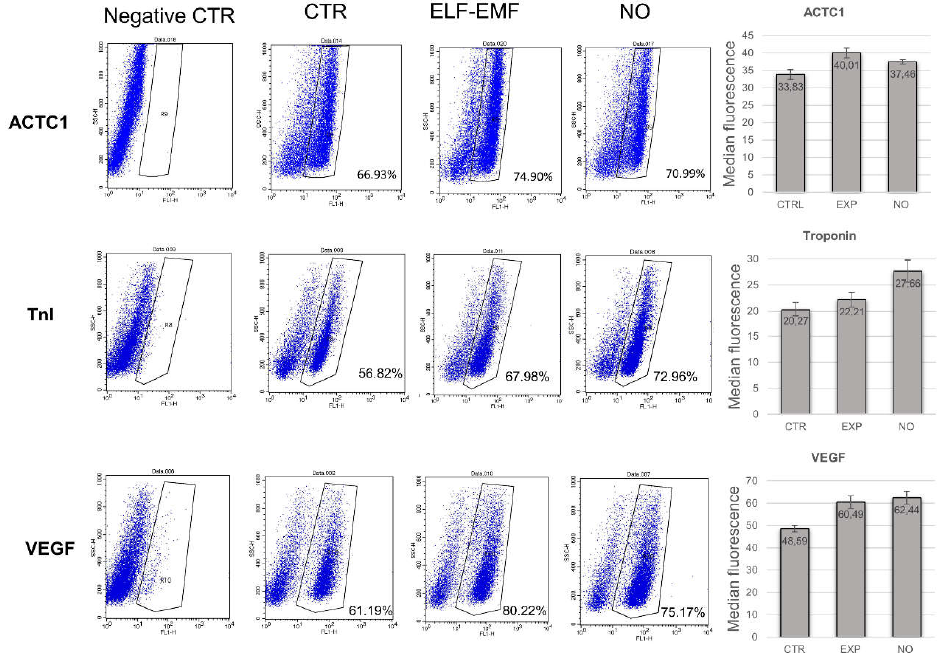
Figure 7. FACS analysis of hAMSCs. The protein expression of TnI, ACTC1, and VEGF after chemical or physical ELF‐EMF treatment was evaluated by flow cytometry. Dot plots show the percentage of positive cells: control cells (CTR), physical exposed cells (ELF‐EMF) and Nitric Oxide treated cells (NO) ( n = 3).